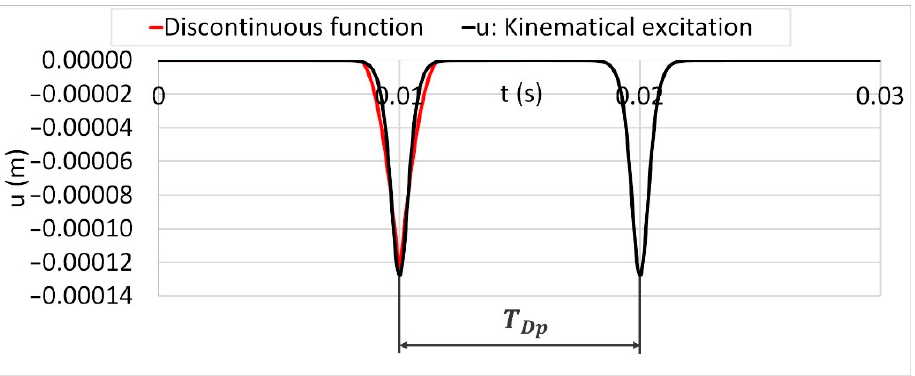
Figure 15. The kinematical excitation compared to the discontinuous function.